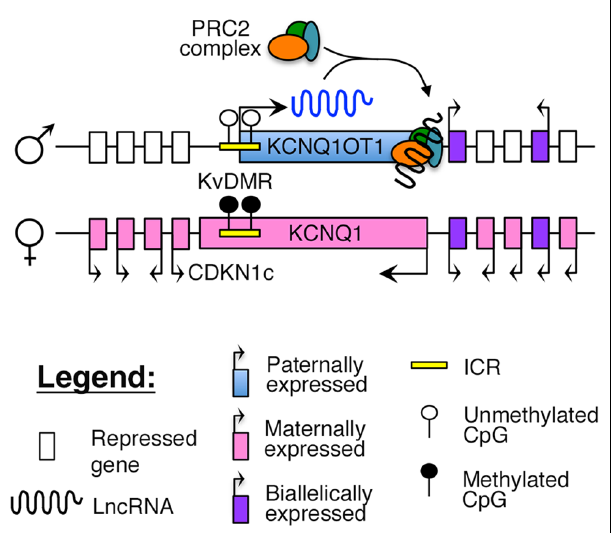
FIGURE 2 | Proposed model of imprinting at the KCNQ1 locus: the KCNQ1OT1 lncRNA is expressed from the paternally unmethylated KvDMR ICR, which is methylated on the maternal allele. Recent evidence suggests that KCNQ1OT1 can directly recruit the PRC2 complex and facilitate intra-chromosomal looping to the KCNQ1 promoter (Zhang etal.,